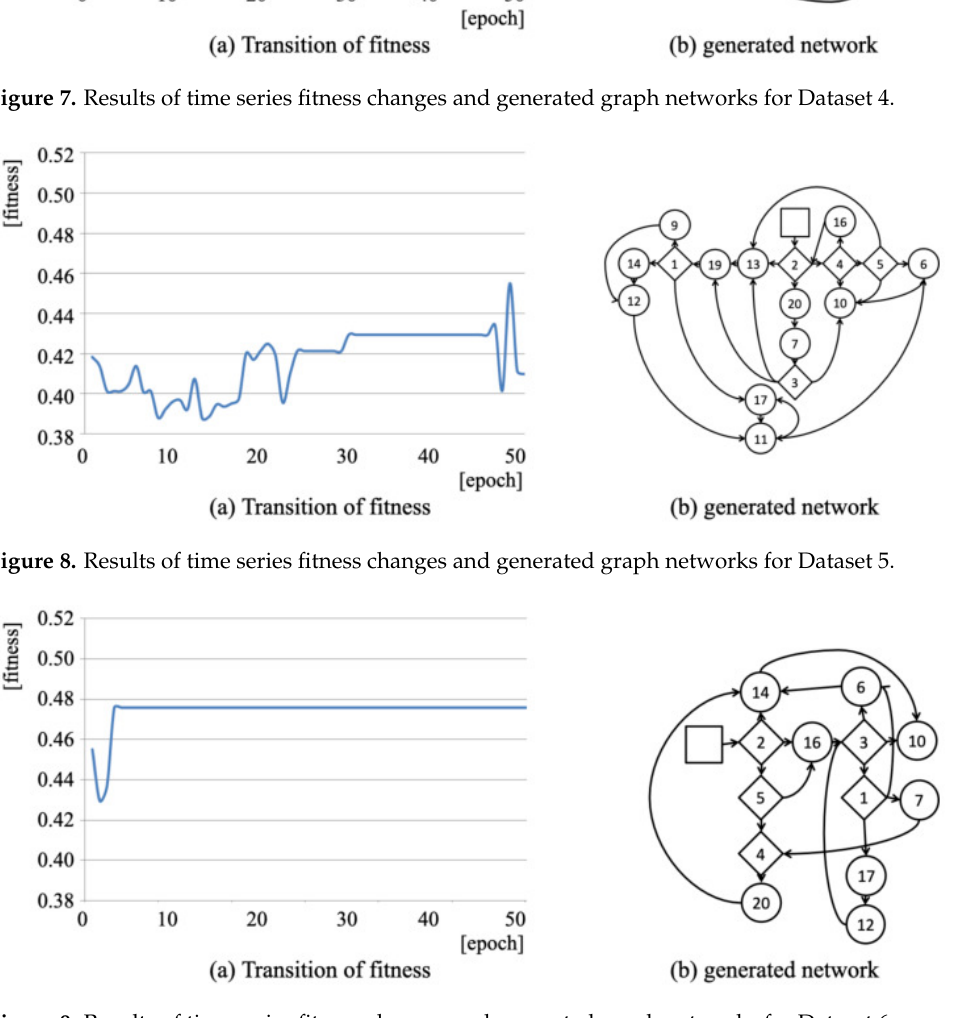
Figure 9. Results of time series fitness changes and generated graph networks for Dataset